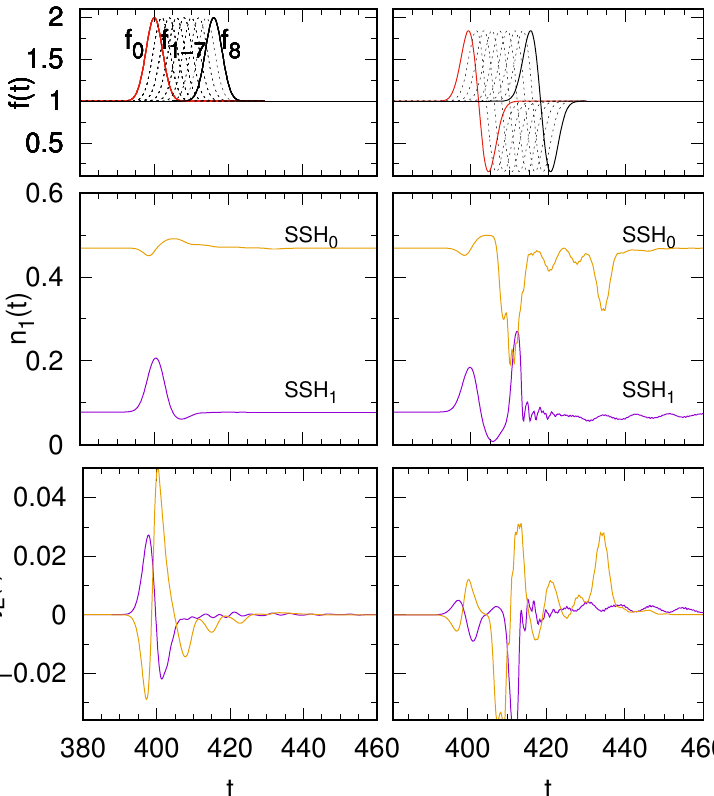
Figure 2. One-Gaussian (left panel) and two-Gaussian (right panel) perturbations of the time- dependent couplings: f 0 (between the left electrode and first wire site, red lines), f i (between i-th and ( i + 1 ) -th sites, broken curves) and f N (between the last chain site and the right electrode, back solid curves)—upper panels. Charge occupation of the first wire site (middle panels) and time-dependent current flowing from the left electrode (bottom panels) for the SSH chain in the trivial phase (yellow lines, V = 4, W = 1, SSH 0 ) and for nontrivial phase (violet lines, V = 1, W = 4, SSH 1 ). The other parameters are: ε 0 = 3, t x = 3, σ = 10, V L = V R = 4, t 00 = 400, t 1 = 4, N =